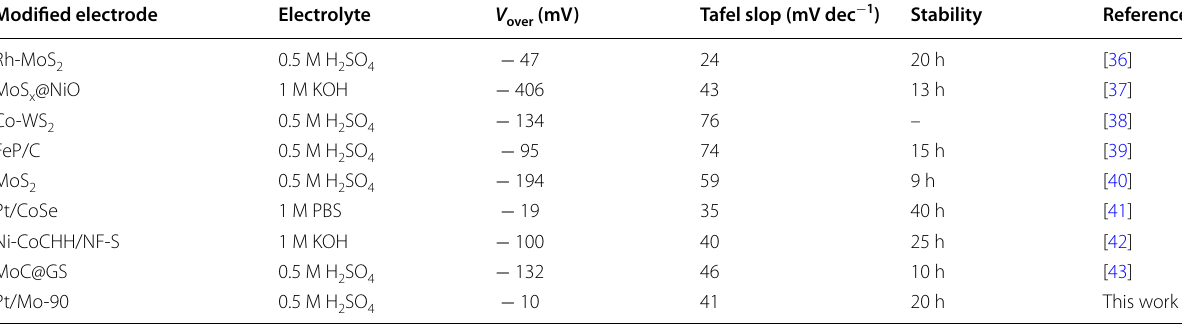
Table 1 A Summary and a comparison of the current work with earlier studies in the literature Modified